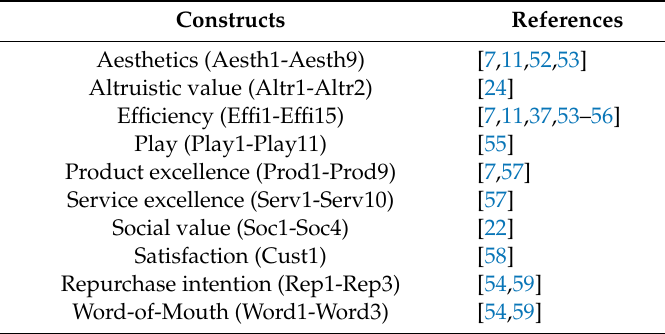
Table 1. Overview of customer value types and consumer behavior outcomes, indicator abbreviations, and all scale references.